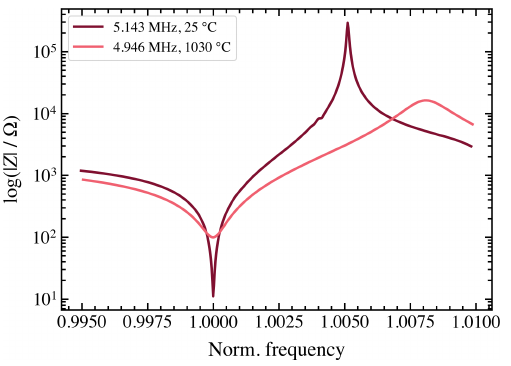
Figure 8. Inverse Q factor of unhoused CTGS resonators from two vendors and of housed